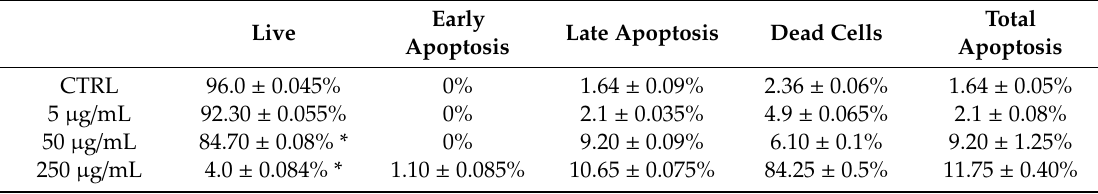
Table 1. Annexin V in CaCo2 cells untreated and treated for 72 h with methanolic extract of B. etnensis Raf. a t different concentrations (5–250 µg/mL). Values are the mean ± SD of four experiments in triplicate. *Significant vs. untreated control cells: p < 0.001.